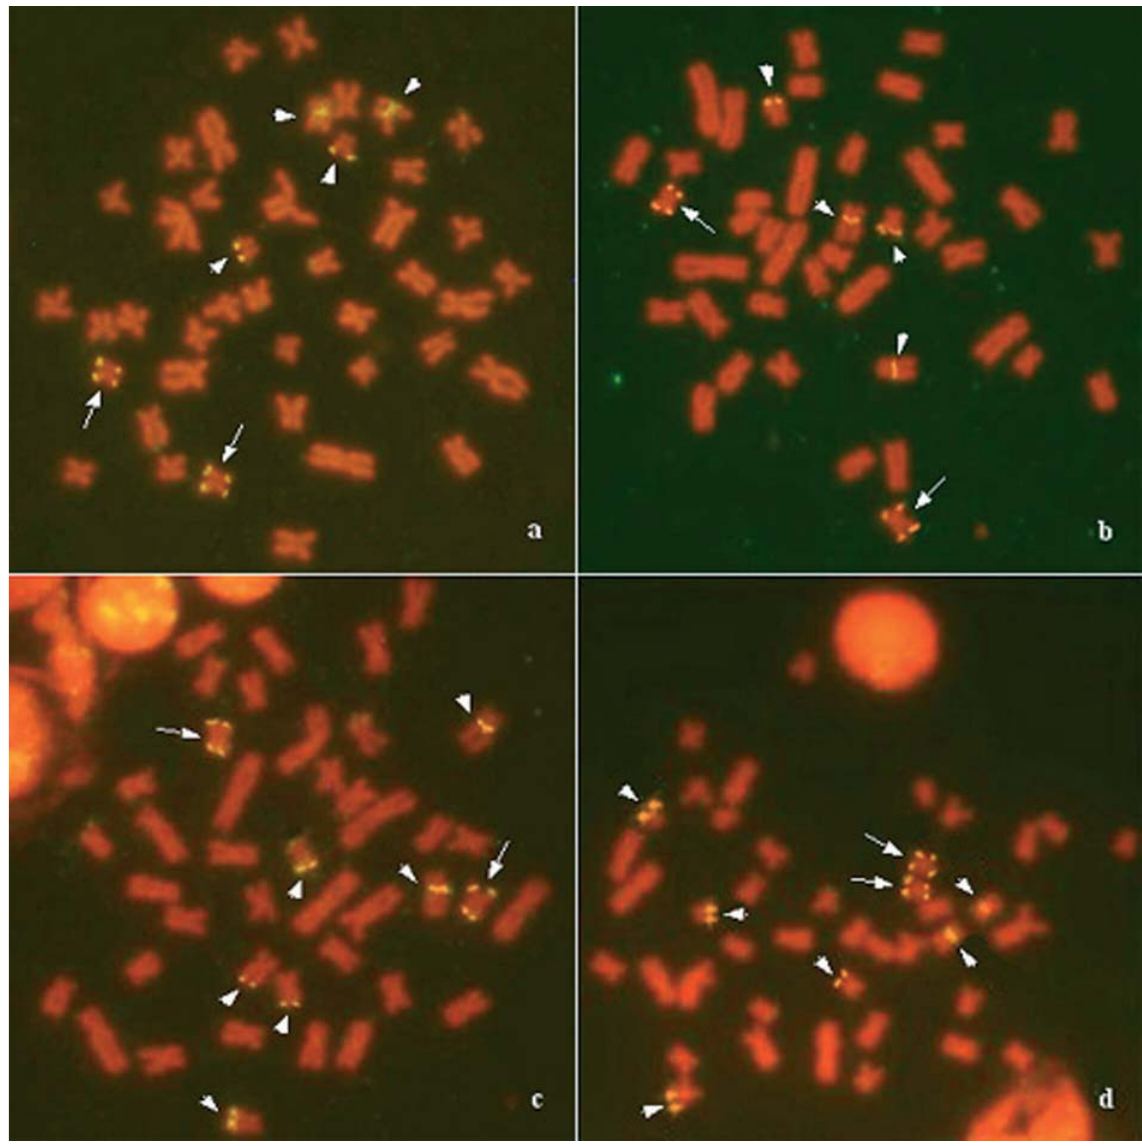
Figure 6 - Metaphases of Hoplias malabaricus from the Ribeira (a), Tibagi (b), Ivaí (c), and Iguaçu (d) populations, showing fluorescent in situ hybrid - ization with 18S rDNA probe. Arrows and arrowheads indicate the bi-telomeric NOR phenotype and the telomeric NORs,